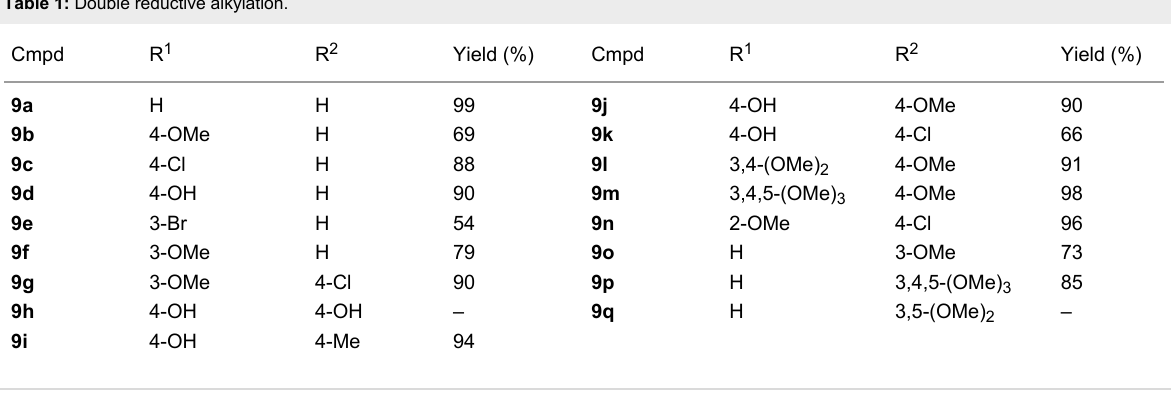
Table 1: Double reductive alkylation. Cmpd